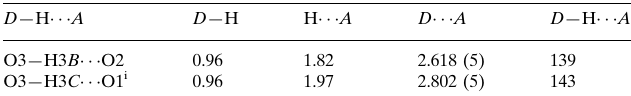
Hydrogen-bond geometry (A˚ , (cid:2)